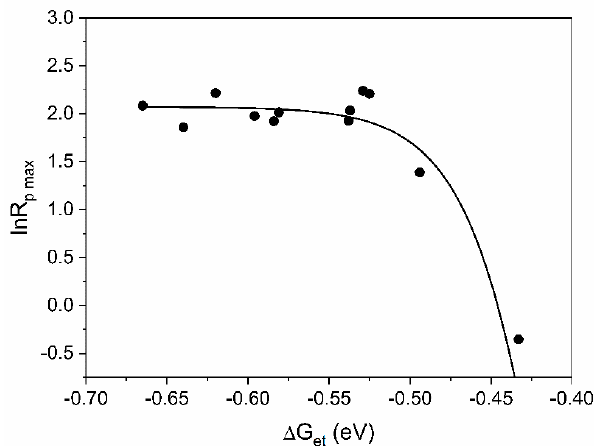
Figure 7. Relationship between the free energy of activation of electron transfer process and the rate of polymerization initiated by the merocyanine dyes and phenyltriethylborate salts. The plot reveals that the rate of free radical polymerization initiated by the photoredox pairs composed of merocyanine dyes and phenyltrialkylborate salt increases as the driving force of the